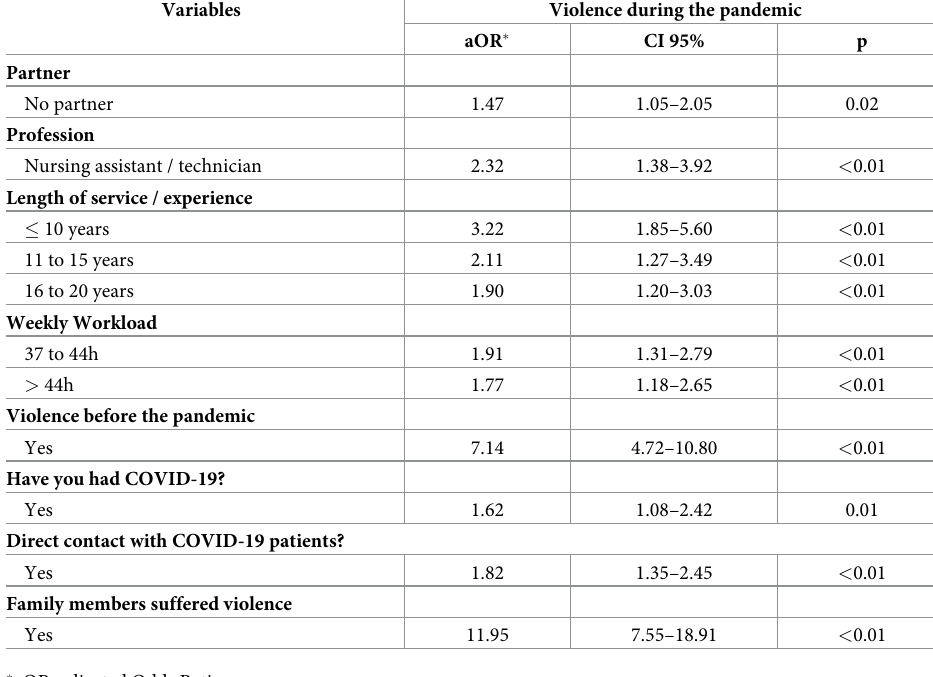
Table 5. Adjusted model of variables to suffer violence during the pandemic.